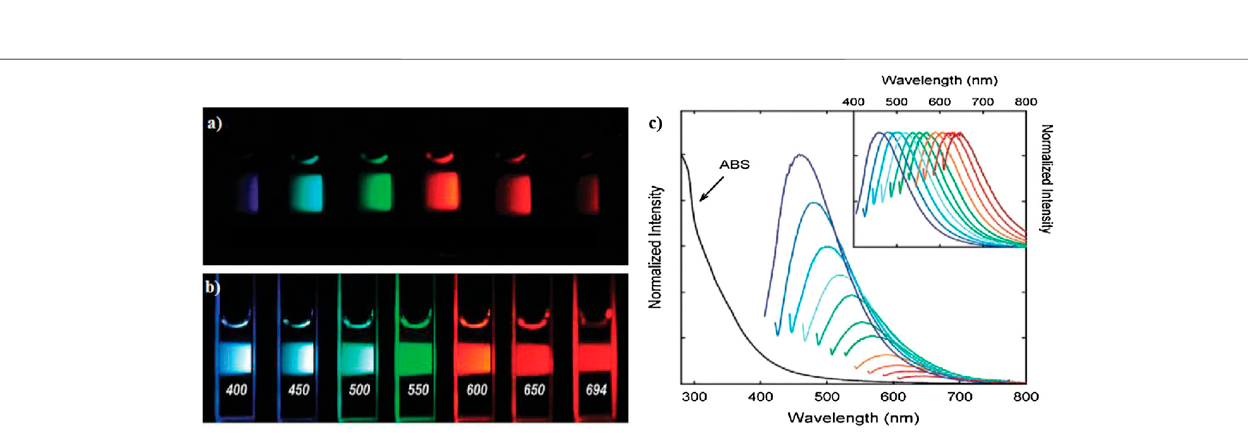
Frontiers in Materials |